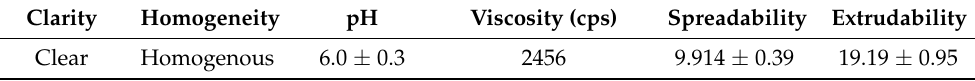
Table 1. Physicochemical characteristics of rutin-SNPs formulations.